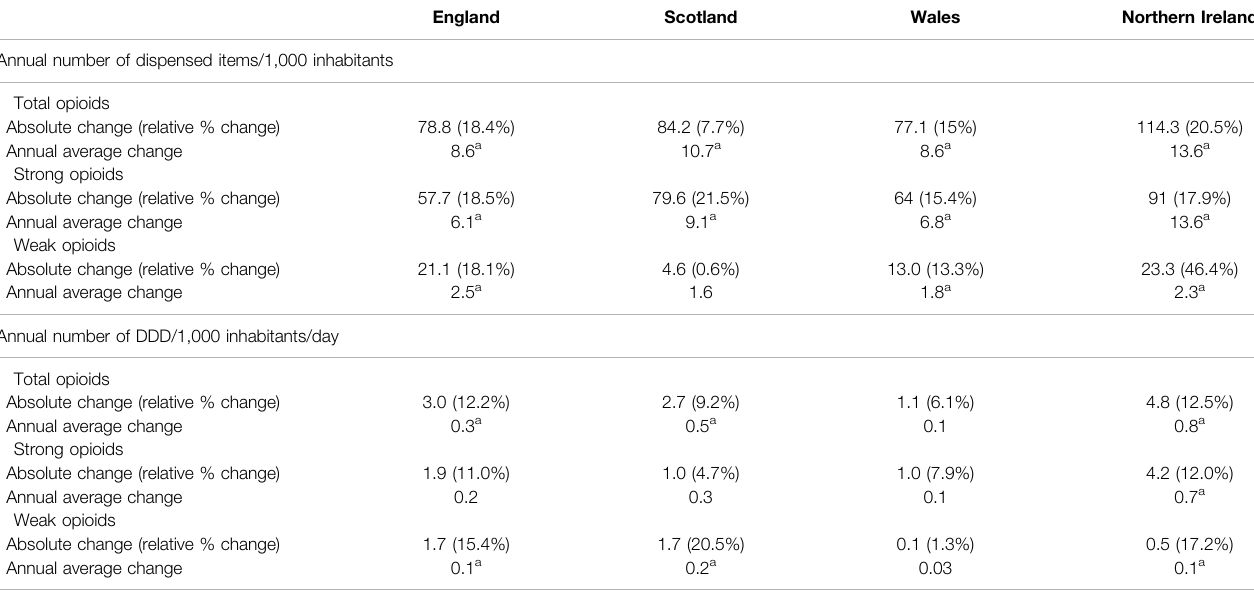
TABLE 1 | Absolute, relative, and average annual changes in the utilisation trends of opioids across England, Scotland, Wales and Northern Ireland over the study period from 2010 to